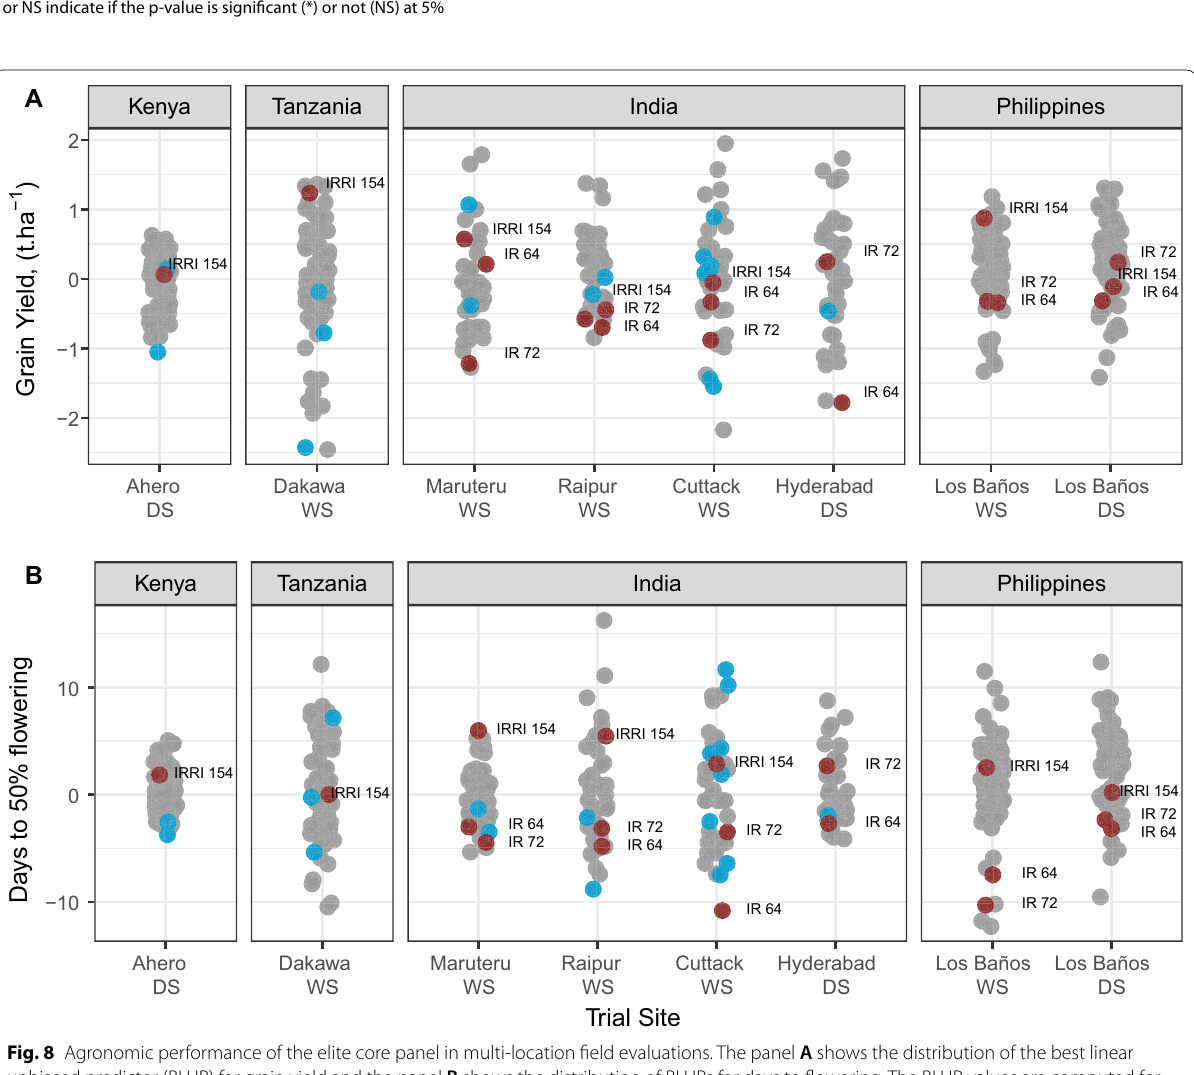
* or NS indicate if the p-value is significant (*) or not (NS) at 5%